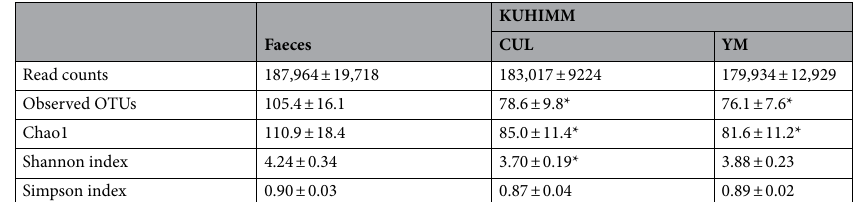
Table 1. Summary of 16S rRNA gene sequencing data and α-diversity values (Chao1 estimator, Shannon index, and Simpson index). Eight human faecal samples, the corresponding culture without yeast mannan (CUL), and the corresponding culture with the 0.4% yeast mannan preparation (YM) were sampled 30 h after the initiation of fermentation. Values are the mean ± standard deviation. Asterisks (*) represent significant differences (* p < 0.05) (n = 8) between microbiota in the original faeces and the microbiota in corresponding cultures without or with yeast mannan using the Kruskal–Wallis test.